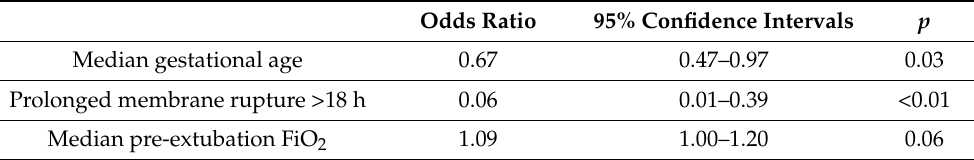
Table 2. Multivariate logistic regression analysis of significant